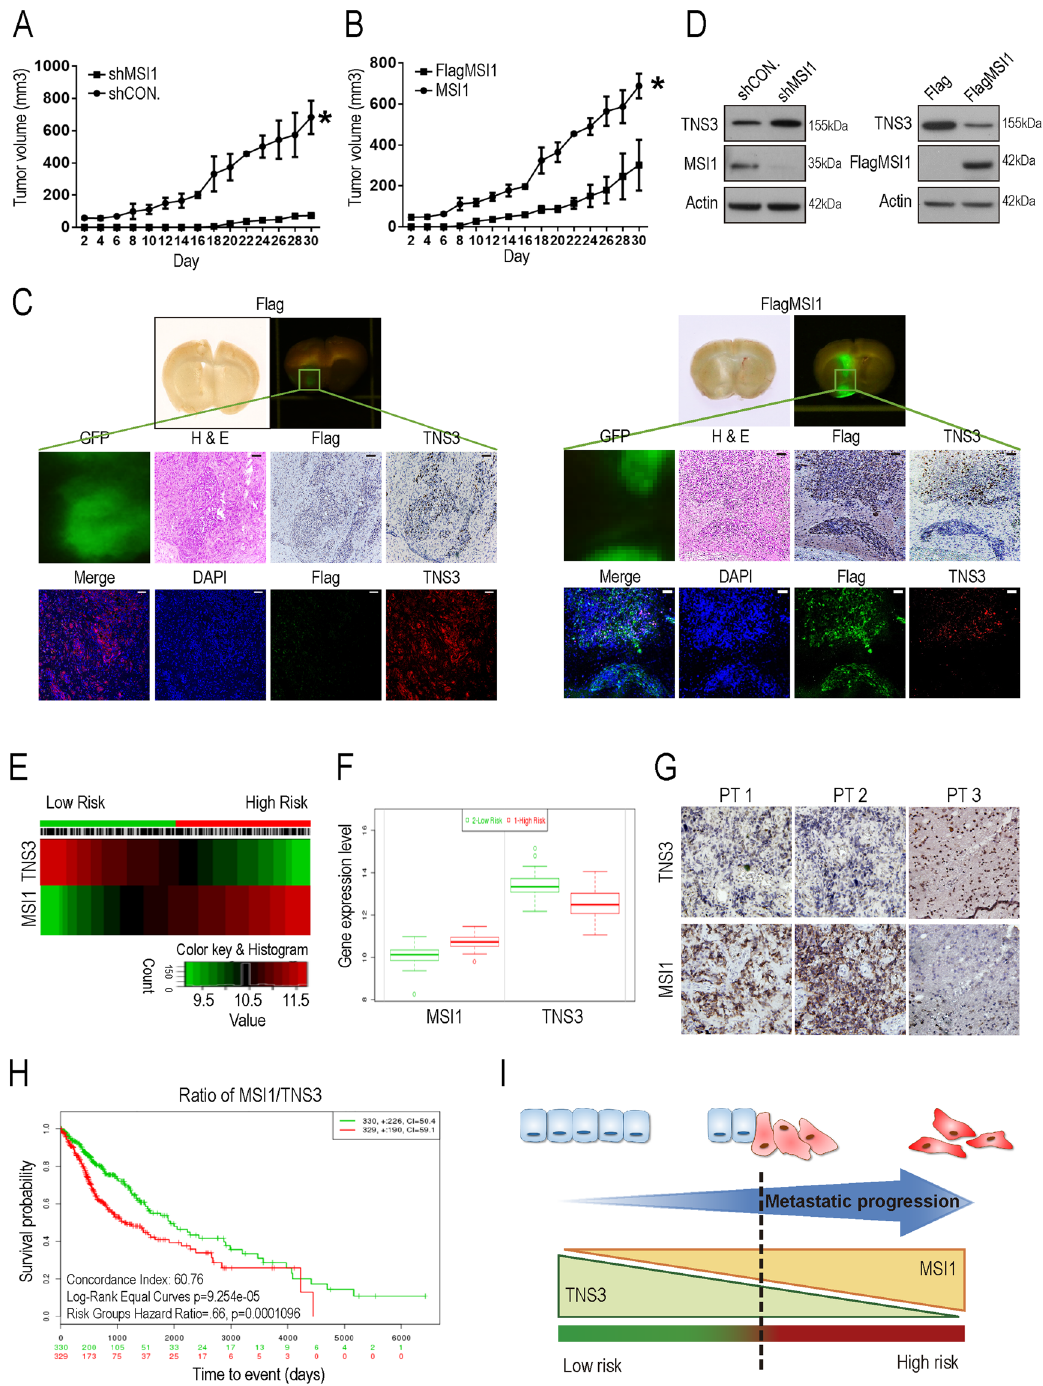
Figure 6. MSI1/TNS3 signaling promoted in vivo tumor migration and correlated with poor patient survival. ( A , B ) In vivo GBM growth rate was assessed by subcutaneous tumor implantation in immunocompromised mice with 5 × 10 5 MSI1-depleted 05MG cells or 5 × 10 5 MSI1-overexpressed U251 cells, each facilitated with their respective controls. Tumor volume was measured by caliper. Data were presented as mean ± SEM (n = 12). * p < 0.05 (relative to the control group). ( C ) SCID mice were orthotopically implanted with 1.5 × 10 5 GFP- labeled U251-Flag-control or 1.5 × 10 5 GFP-labeled U251-MSI1-ovexpressed cells. Representative photographs of fluorescent images were taken 63 days after inoculation. The GFP-labeled GBM tumors can be observed and the tumor sections were subjected to H&E, IHC, and IF staining to assess tumor malignancy, spreading, as well as the expression of MSI1 and TNS3. ( D ) Tumor tissue was harvested and homogenized for western blotting to assess MSI1 and TNS3 protein levels ex vivo . The uncropped blots were demonstrated in Supplementary Figure 5. Correlation of survival rates and MSI1/TNS3 gene expression in GBM patients. ( E ) Heat map of MSI1 or TNS3 mRNA expression of GBM patient samples along with the risk factor. The high and low risk